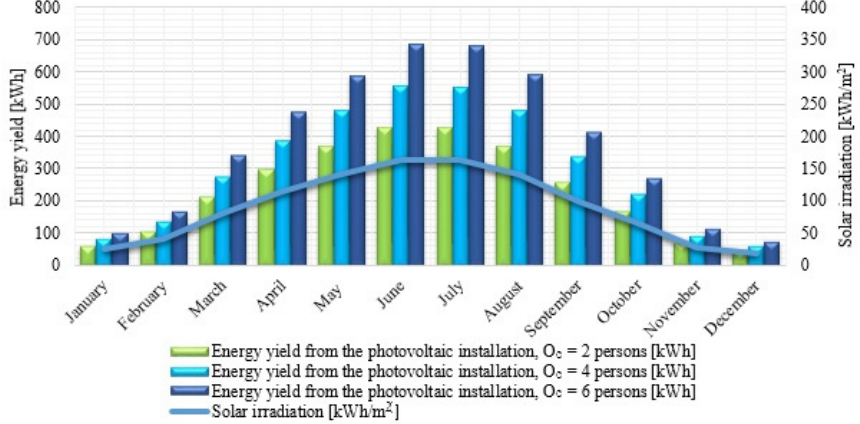
Figure 12. Monthly energy yields from PP installations [kWh] and solar radiation intensity [kWh/m 2 ].